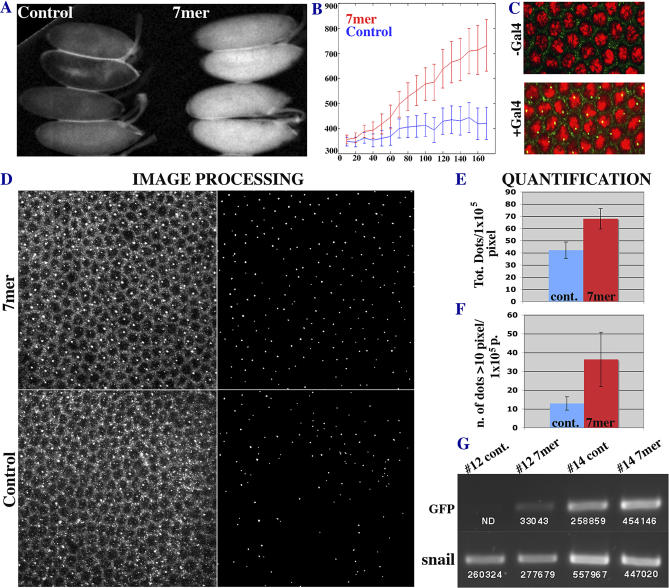
The CAGGTAG Motif Activates Transcription prior to Cycle 14(A) Transgenic embryos over-expressing GFP with (7mer) or without (control) the 7mer. Five copies of the 7mer were obtained by crossing males carrying the specific transgene to females providing Gal4. GFP expression was monitored using video microscopy. In (A), a single frame is shown.(B) Fluorescent GFP quantification at 20-min intervals.(C) FISH showing the GAL4 dependence of the 7mer-mediated GFP transcription. Only one major dot is observed per nucleus because males carrying the transgene were crossed to females supplying Gal4.(D) FISH analysis of embryos over-expressing GFP with (7mer) or without (control) the 7mer. Images were processed and quantified as described in Materials and Methods.(E and F) Quantification of the number and size of nuclear dots. Results were expressed as number of dots per 1 × 105 pixels. In (F), only dots larger than ten pixels were quantified.(G) RT-PCR quantification. Control and 7mer embryos were harvested at the indicated cycles (12 and 14), and the amount of GFP transcripts quantified using the FluorChem gel documentation system equipped with a CCD camera. The numbers below the bands are the result of this measurement. ND, non-detected.